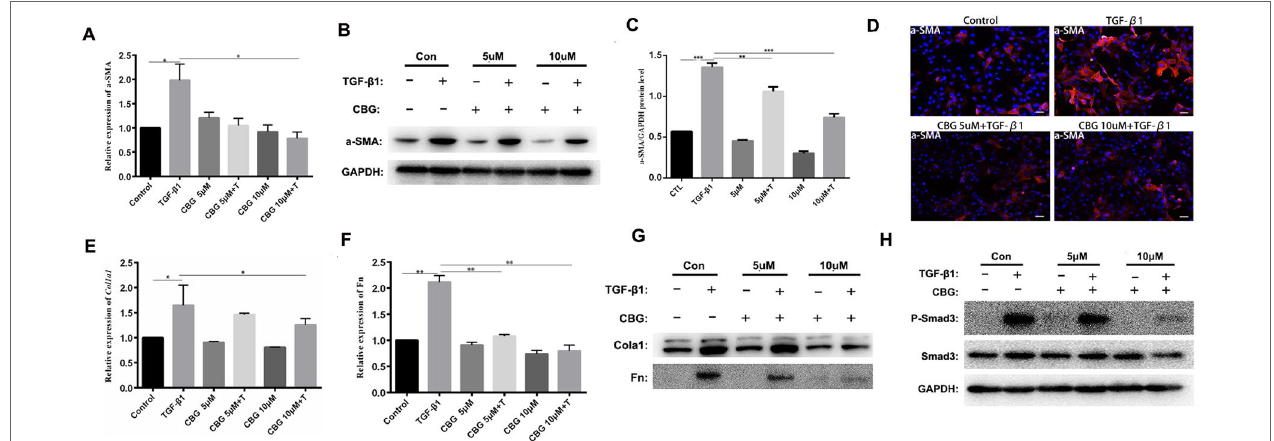
FIGURE 3 | Cinobufagin inhibits TGF- β 1-induced expression of α -SMA, Col1 and Fn in vitro . Mlg cells were treated with TGF- β 1 (5 ng·ml −1 ) and cinobufagin (5 and 10 μM) for 24 h (n = 3 per group). The mRNA levels of α -SMA (A) , Col1a1 (E) and Fn (F) were analyzed by Real-time PCR. The protein levels of α -SMA (B, C) , Col1a1, Fn (G) and P-Smad3 (H) were analyzed by western blot. (D) Immunofluorescence staining for α -SMA (a marker of myofibroblast differentiation) was performed on Mlg cells treated with/without TGF- β 1 (5 ng·ml −1 ) and/or cinobufagin (5 and 10 μM) for 24 h. *P < 0.05; **P < 0.01; ***P <